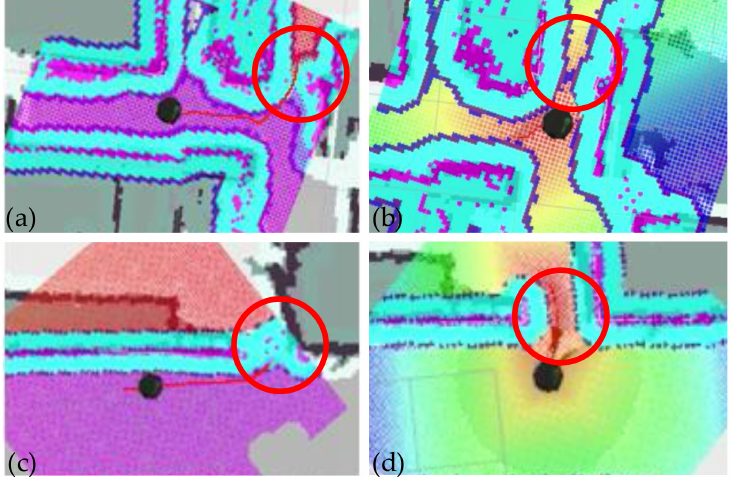
Figure 10. Generation and elimination of observation error. ( a , c ) Erroneous obstacle in the red circle blocks the path. ( b , d ) Error is eliminated when robot is at the